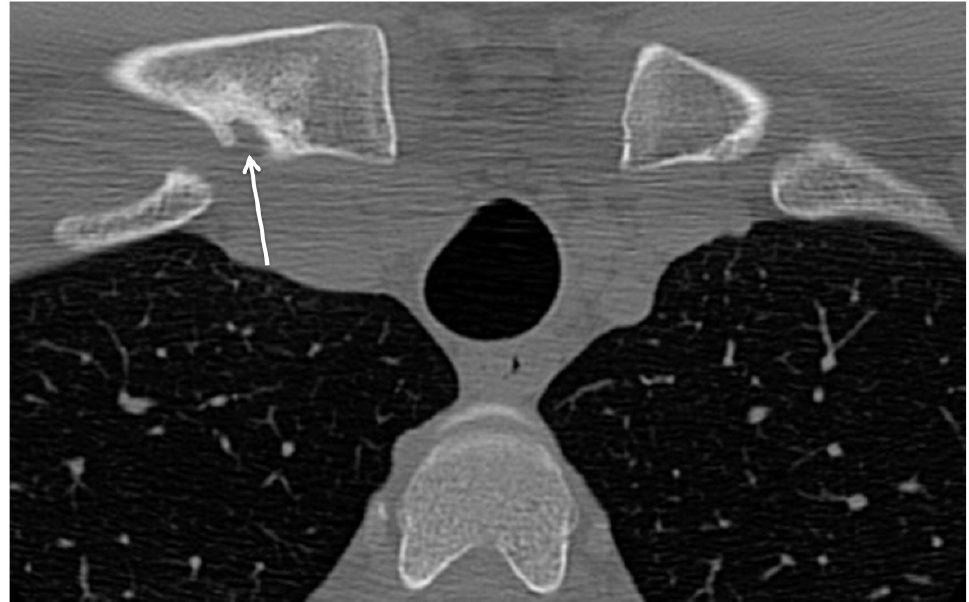
Figure 9. Axial CT image confirms mixed blastic and erosive changes along the medial clavicle (arrow).